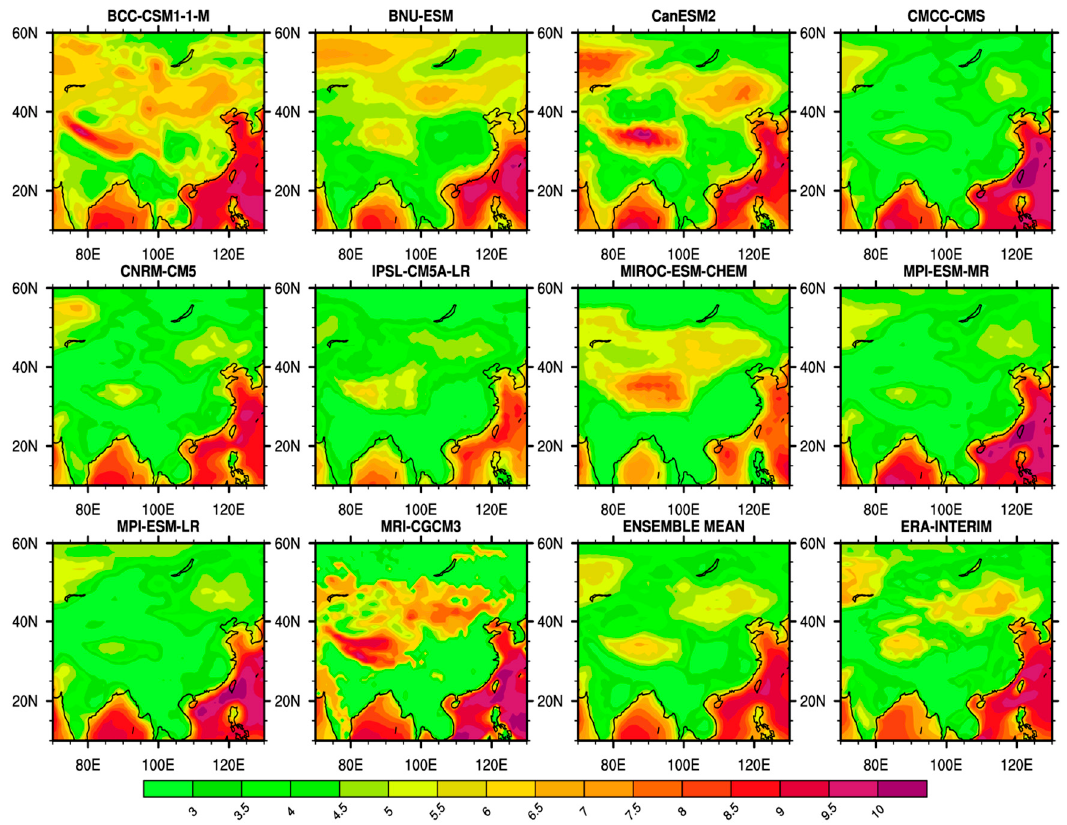
Figure 3. Spatial distribution of mean wind speed (m / s) extrapolated to 90 m above ground level for the current period of 1981–2005 for the CMIP5 models, their ensemble mean, and ERA-Interim.